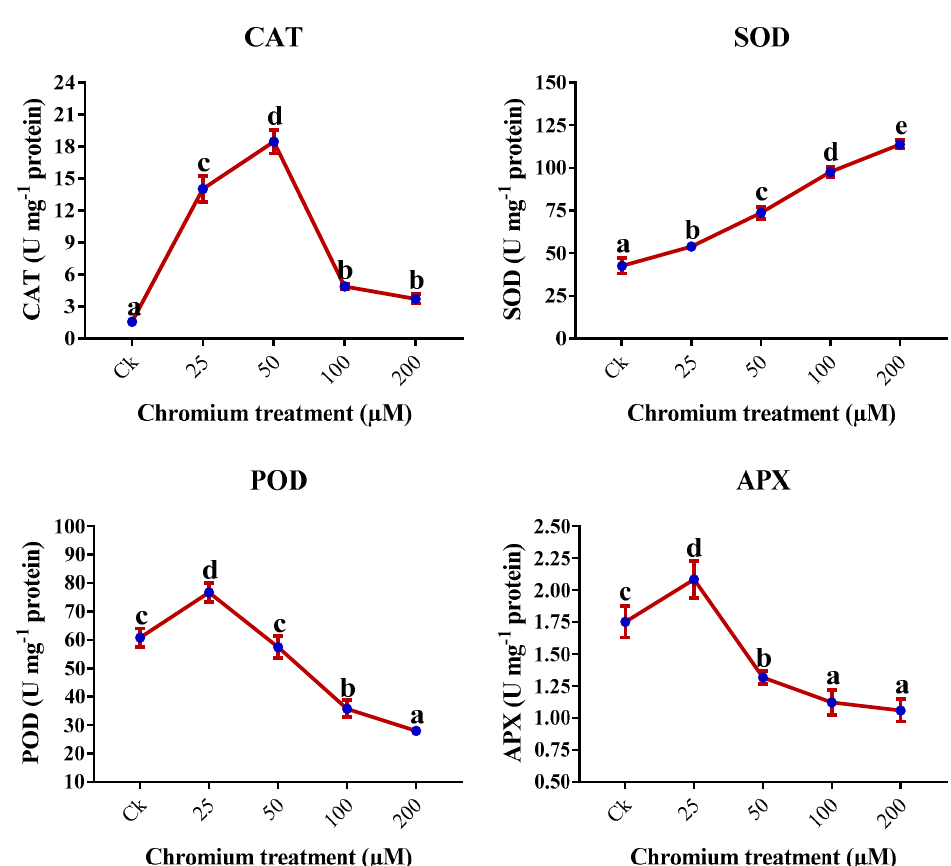
Figure 7. Impact of Cr on the antioxidant enzymes in the leaves of sweet potato. Means followed by different letters indicate a significant difference ( p < 0.05) among the five treatments according to the Tuckey test. Error bars show mean ± SE. Table 5. Impact of Cr in the content of Cr in the sweet